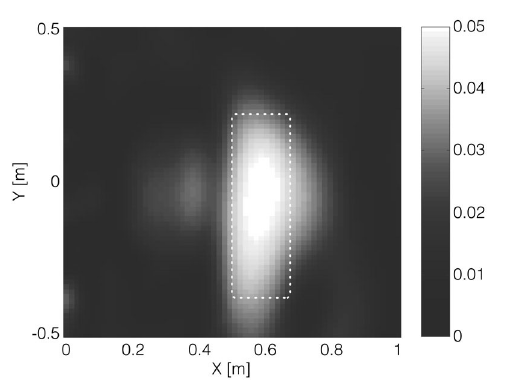
Fig. 8. Case 2: a conductivity anomaly. Modulus of the reconstructed contrast when considering clean data. The reference shape is reported as a contour